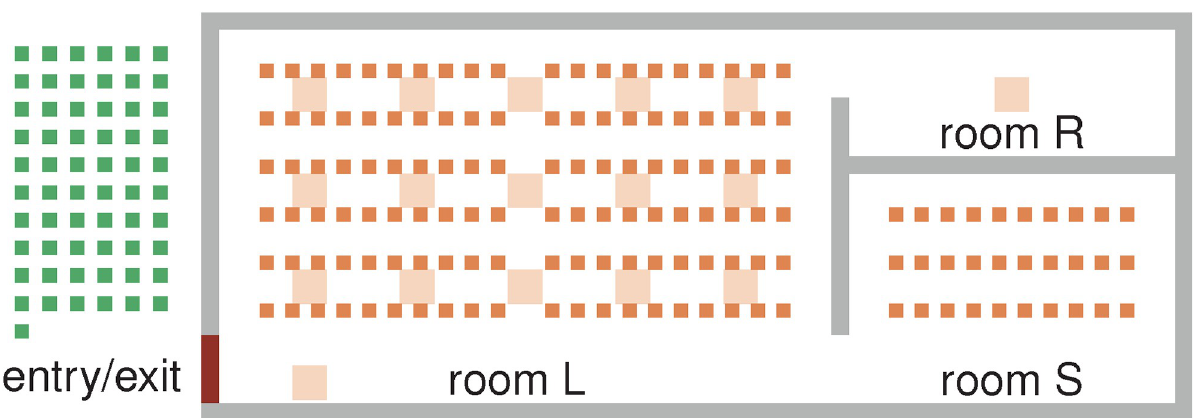
Fig 7. Topography of the choir practice scenario. A large (L) hall, a small (S) room and a restroom (R). Virtual persons are spawned by sources (green), they approach an intermediate target, remain there for a given period and move to the next one (targets all orange). Small orange squares represent chairs. Large, light orange squares define positions where virtual persons gather in small groups during the break.